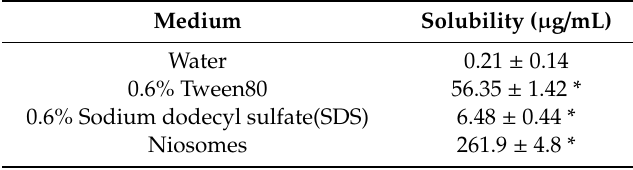
Figure 7. ( a ) Quercetin in oil at different pH; ( b ) Quercetin in water at different pH. Table 4. Solubility of Quercetin in water, surfactants, and niosomes. Medium Solubility ( µ g / mL) Water